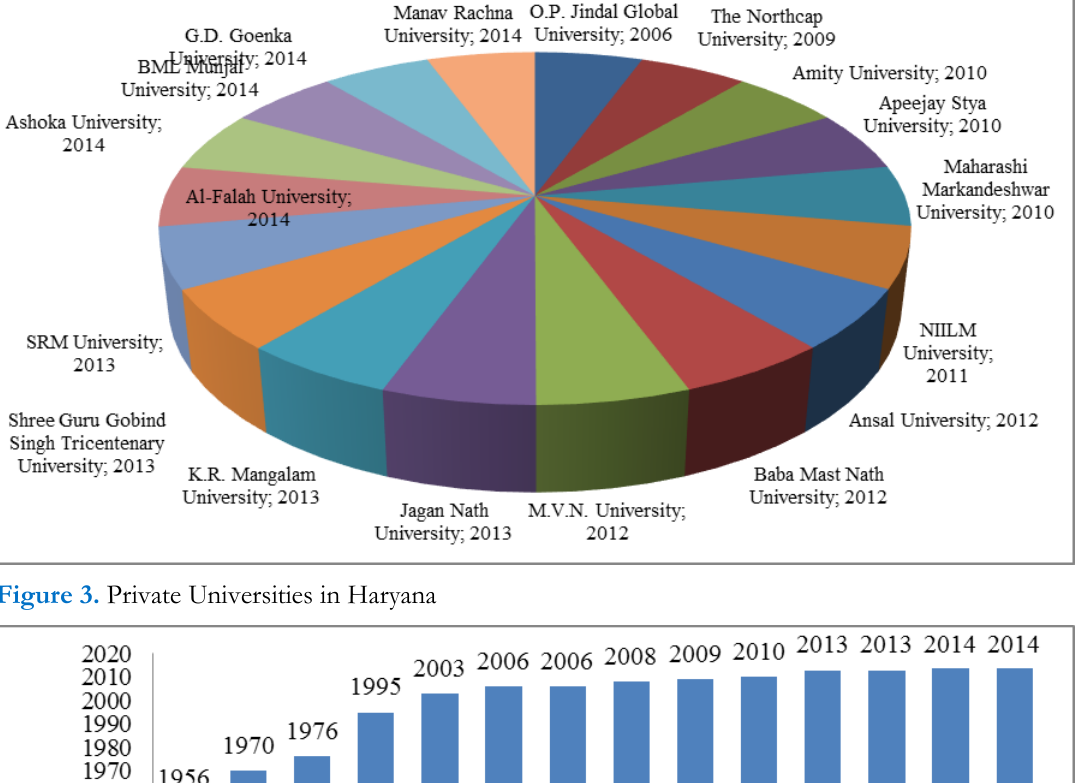
Figure 3. Private Universities in Haryana